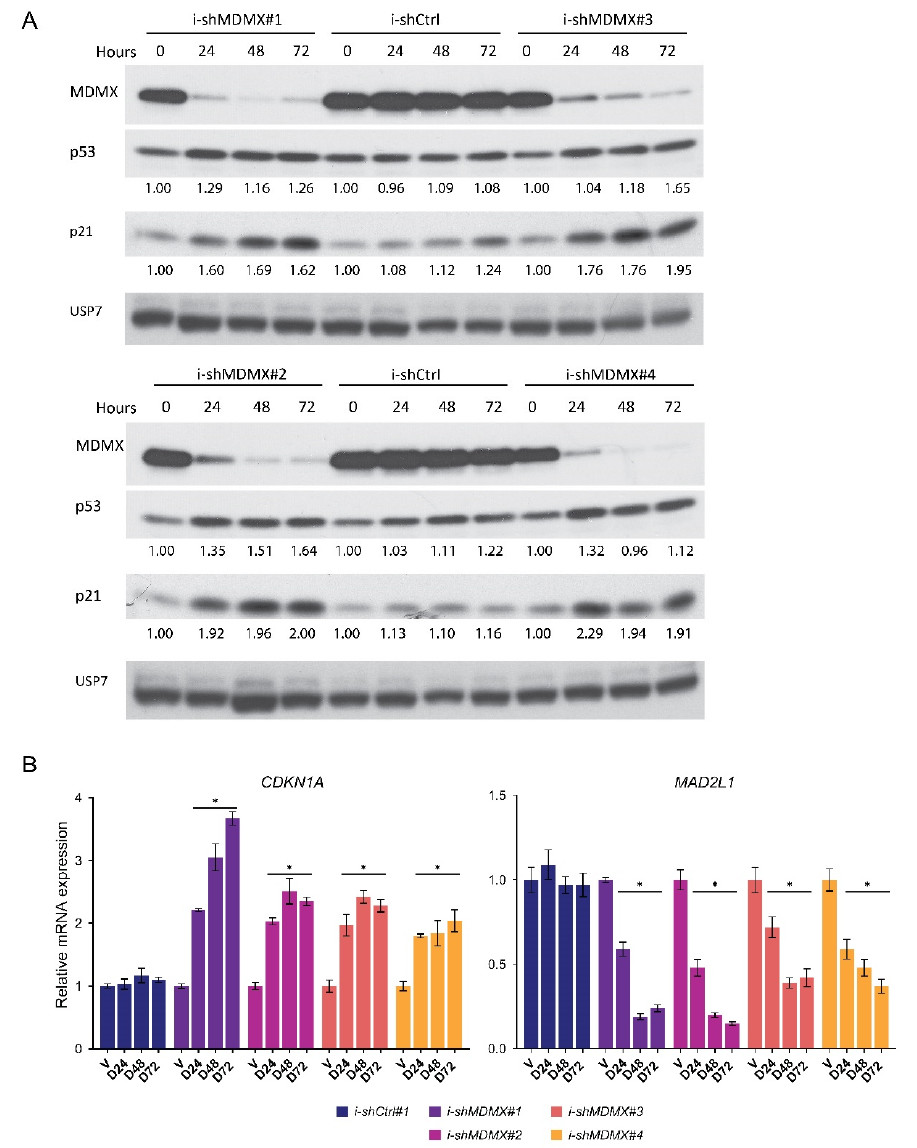
Figure 1. Kinetics of p53 activation upon MDMX depletion in MEL202 cells. ( A ) Protein expression analysis of i-shCtrl and i-shMDMX MEL202 cells harvested after different incubation periods with doxycycline (0, 24, 48 and 72 h). The cells containing the distinct MDMX targeting shRNA constructs (#1, 2, 3 and 4) show a clear reduction of MDMX protein upon doxycycline treatment (10 ng/mL). Simultaneously with MDMX depletion, p53 levels slightly increase and p21 CIP1 levels rise, mostly at the later time points. ( B ) Normalized, relative mRNA expression of CDKN1A and MAD2L1 in i-shCtrl and i-shMDMX MEL202 cells harvested after different incubation periods with doxycycline (D; 10 ng/mL) or Vehicle (V). Expression of CDKN1A is markedly increased upon MDMX depletion already after 24 h and only slightly increases at later time points. Repression of MAD2L1 upon MDMX depletion takes approximately 48 h before reaching a plateau. Significant alterations ( p < 0.05) in expression levels are indicated with *. Original blots see Supplementary File